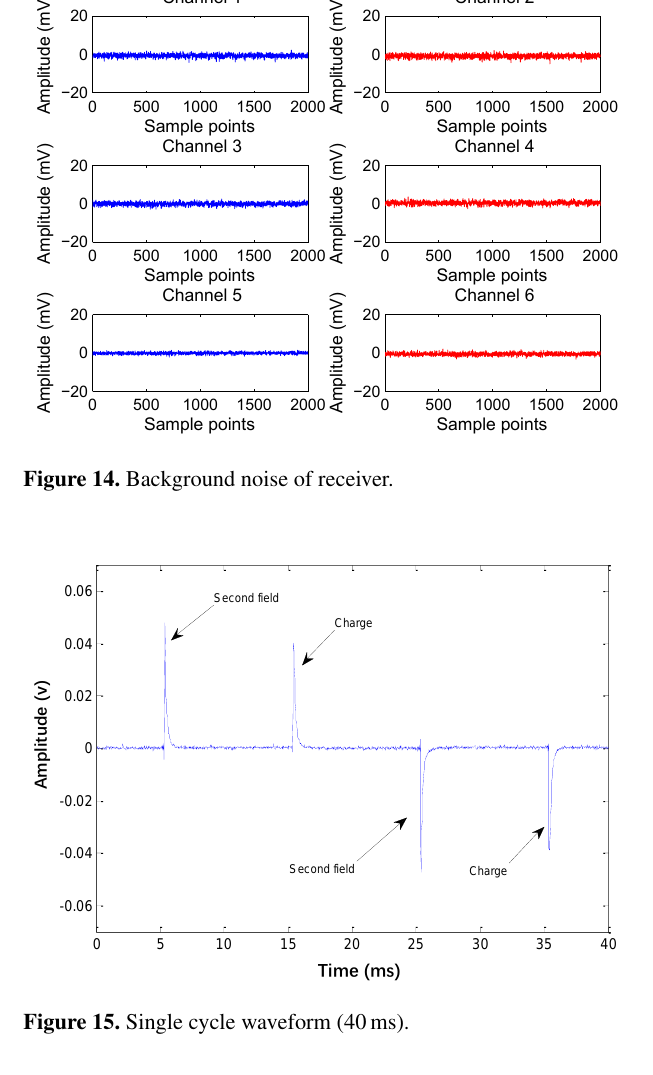
Figure 17. Waveform diagram of data collected in mining